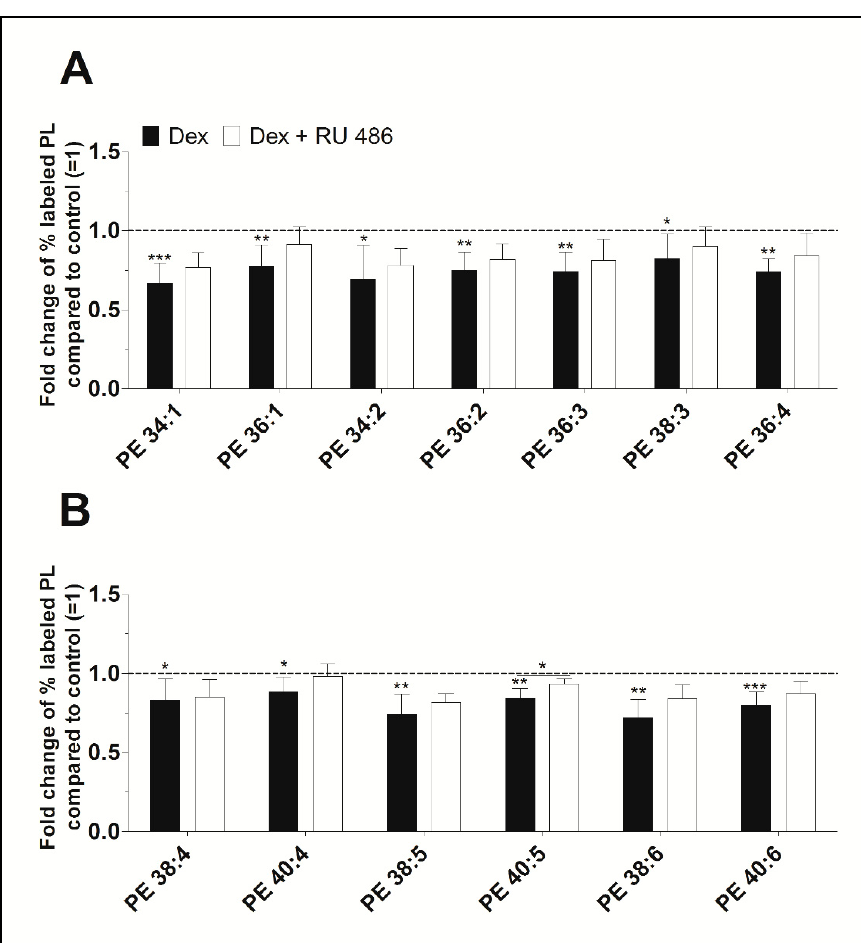
Figure 3. The effect of dexamethasone on the biosynthesis of the PE species ( A ) PE 34:1 to PE 36:4, and ( B ) PE 38:4 to PE 40:6 as modulated by the glucocorticoid receptor antagonist RU 486. PE biosynthesis was monitored by ESI-MS/MS in the presence of dexamethasone (Dex, black bars) alone or together with RU 486 (white bars) for 16 h ( n = 5). The percentages of stable isotope-labeled PE species were calculated and then normalized as ratios of the corresponding untreated controls. Thus, data are presented as means ± SDs of the x-fold change of % labeled PE species compared to the untreated controls (=1). * p ≤ 0.05, ** p ≤ 0.01, *** p ≤ 0.001. PE = phosphatidylethanolamine.